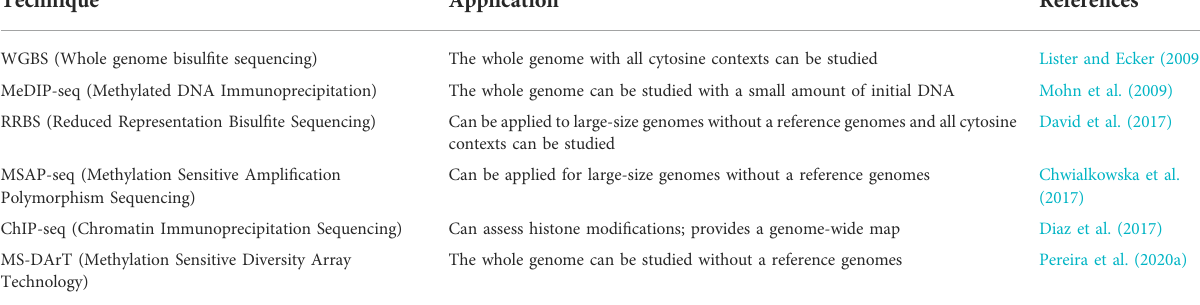
TABLE 6 Commonly used NGS-based techniques for epigenetic